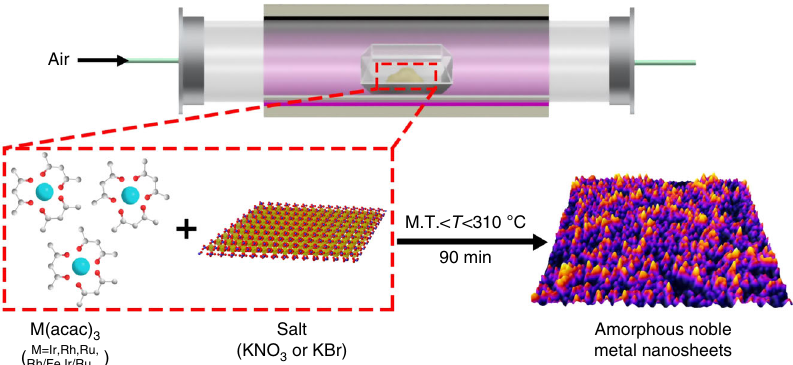
Fig. 1 Schematic illustration of the general synthetic process for amorphous noble metal NSs. Note: M.T. is the melting point of